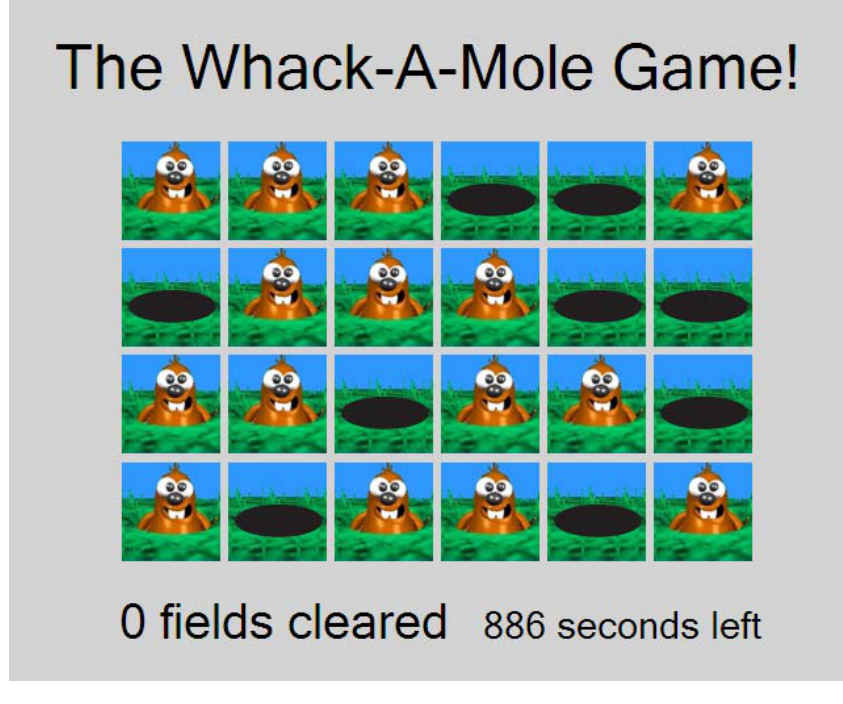
Figure 1. Computer screenshot of the real effort